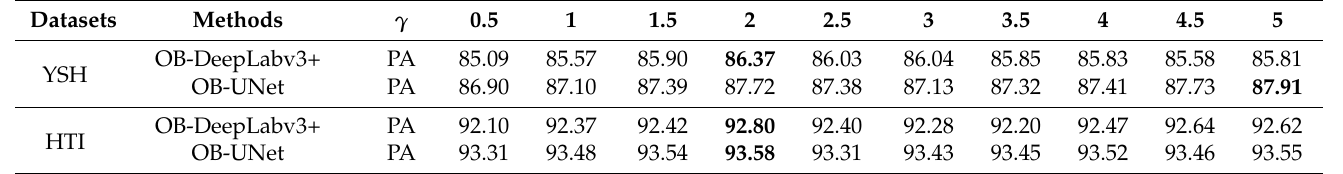
Table 4. The influence of the setting of γ on PA. The entries in bold denote the best on the corresponding dataset. Datasets